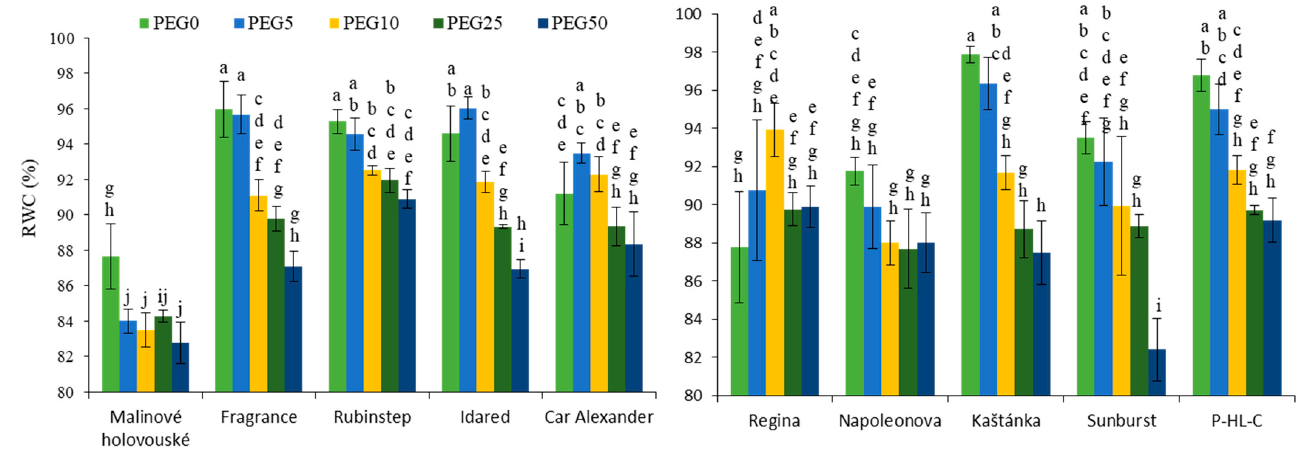
Figure 2. Effect of PEG-6000 concentration on the relative water content (%) for in vitro culture of apple ( left ) and cherry ( right ) cultivars. Error bars represent standard deviation (SD). Values within column, followed by the same letter(s), are not significantly different according to Tukey’s test ( p < 0.05).